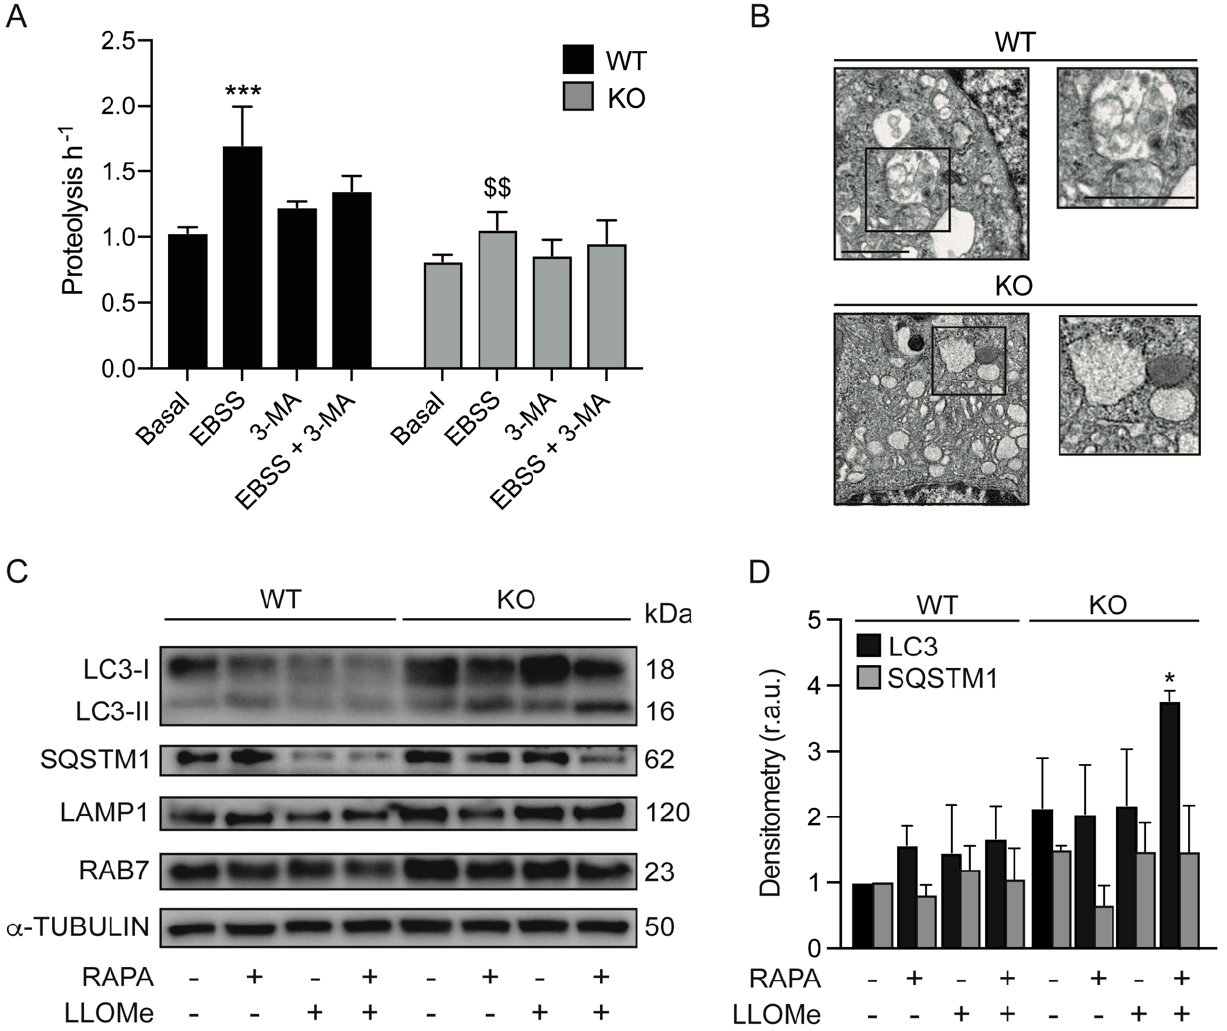
Figure 4. KEAP1 knockout induces autophagic changes. ( A ) WT and Keap1 KO MEFs were cultured under basal conditions or incubated with nutrient-free (EBSS) medium alone or in combination with 10 mM 3–methyladenine (3–MA) for 2 h. Long-lived protein degradation was determined with a pulse-chase assay, as indicated in the Materials and Methods section. Data are the means ± SD of at least three independent experiments and they were analyzed using two-way ANOVA following by Tukey’s multiple comparisons test (*** p < 0.001 vs. basal condition and $$ p < 0.01 vs. WT cells). ( B ) Representative TEM micrographs of WT and Keap1 KO MEFs show different structures. The scale bar represents 2 µm. ( C ) WT and Keap1 KO MEFs were cultured in control conditions or incubated with 1 mM of LLOMe for 1 h followed by a washout step of 4 h. Additionally, one condition involved treatment with 1 µM rapamycin in the last 2 h of the washout. LC3, p62, LAMP1 and RAB7 were assessed with immunoblotting. α -tubulin was used as a loading control. ( D ) Densitometry was employed to quantify the abundance of the indicated proteins normalized to α -tubulin. Data are the means ± SD of at least three independent experiments and they were analyzed using two-way ANOVA following by Sidak’s multiple comparisons test (* p < 0.05 vs. WT cells).